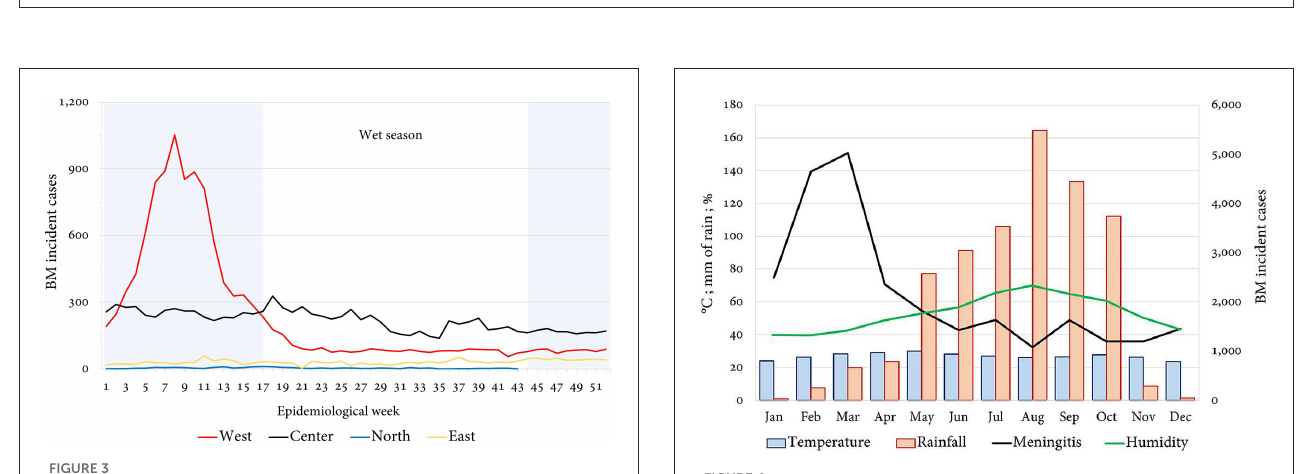
FIGURE2 Geographical distribution of BM cumulative incidence per 100,000 population (A) , according to the etiological agent: N. meningitidis (B) , H. influenzae (C) , and S. pneumoniae (D) . Countries’ land borders colored in red (west), black (central), blue (north), and yellow (east) delimit AMB sub-regions.